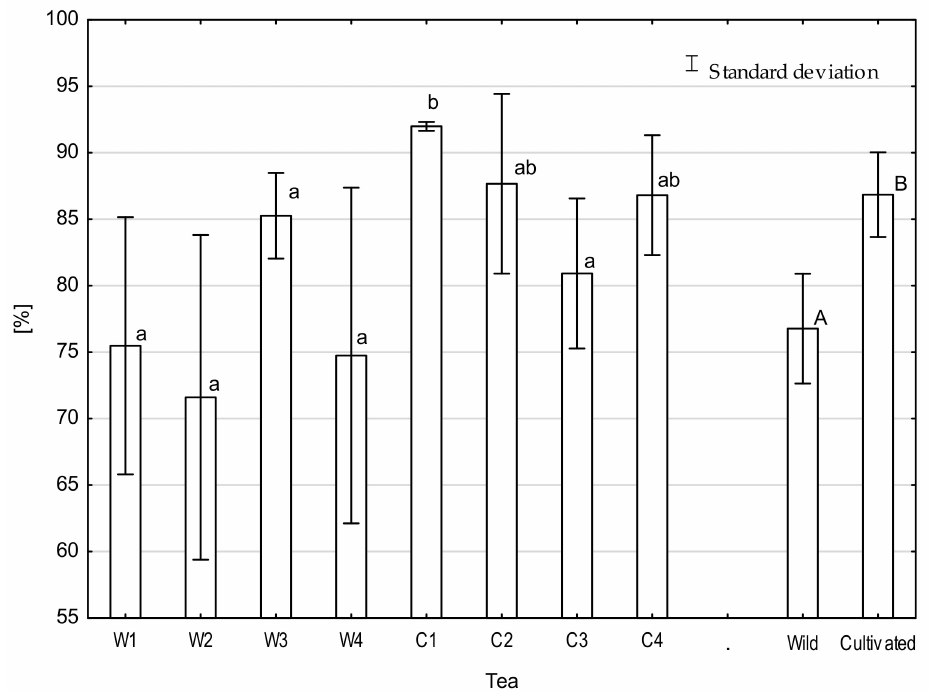
Figure 4. The DPPH radical-scavenging activity of analyzed tea. Means with different letters are significantly different, according to Tukey’s test ( p ≤ 0.05). W1-wild tea, Wuzhishan; W2-wild tea, Baisha; W3-wild tea, Kunlushan; W4-wild tea, Pu’Er; C1-cultivated tea, Wuzhishan; C2-cultivated tea, Baisha; C3-cultivated tea, Kunlushan; C4-cultivated tea,